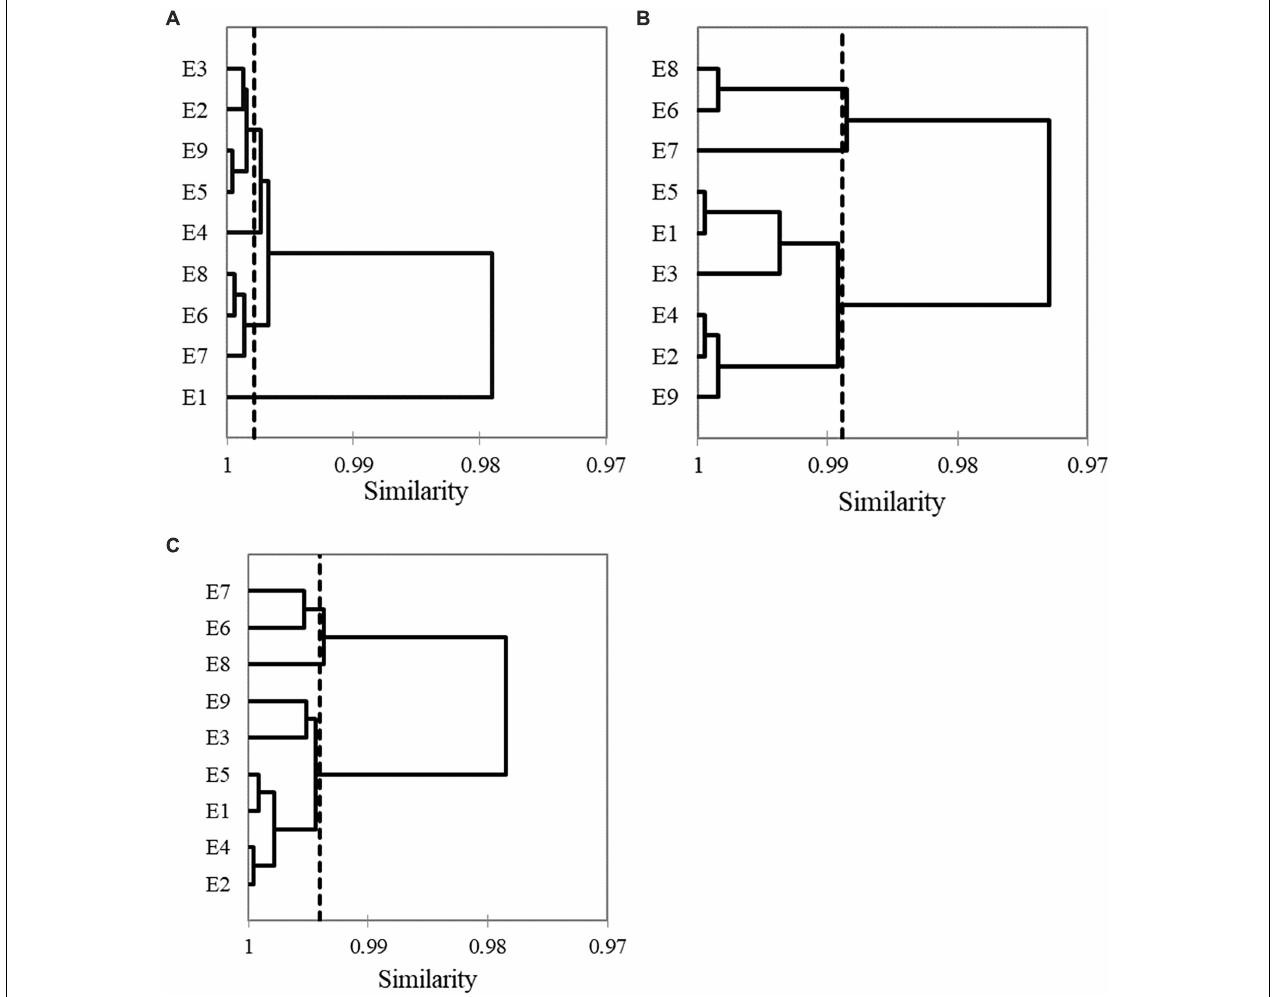
FIGURE 7 | Cluster analysis of hydrological averaged data. (A) 2015; (B) 2016; (C)